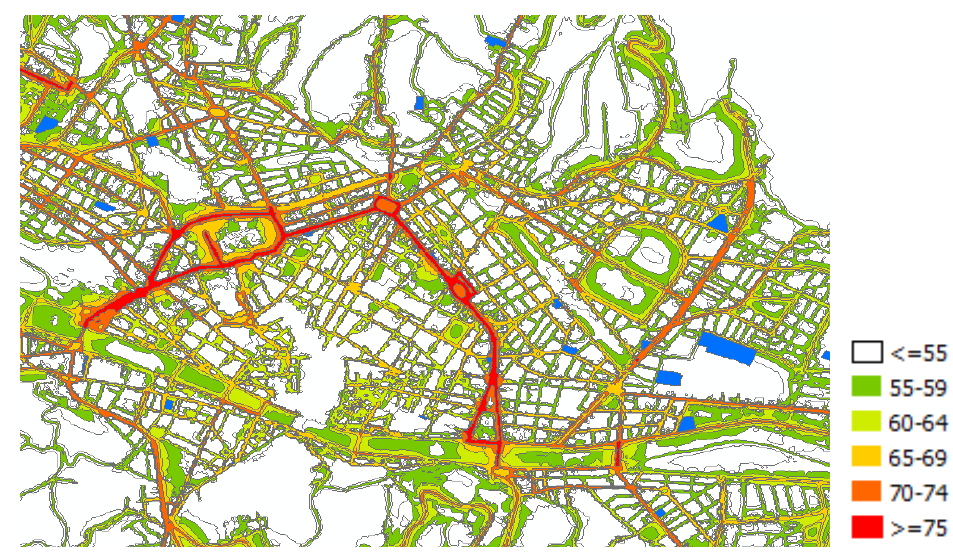
Figure 9. Distribution of the primary and secondary schools of Florence (in blue) in the noise map of the Municipality.